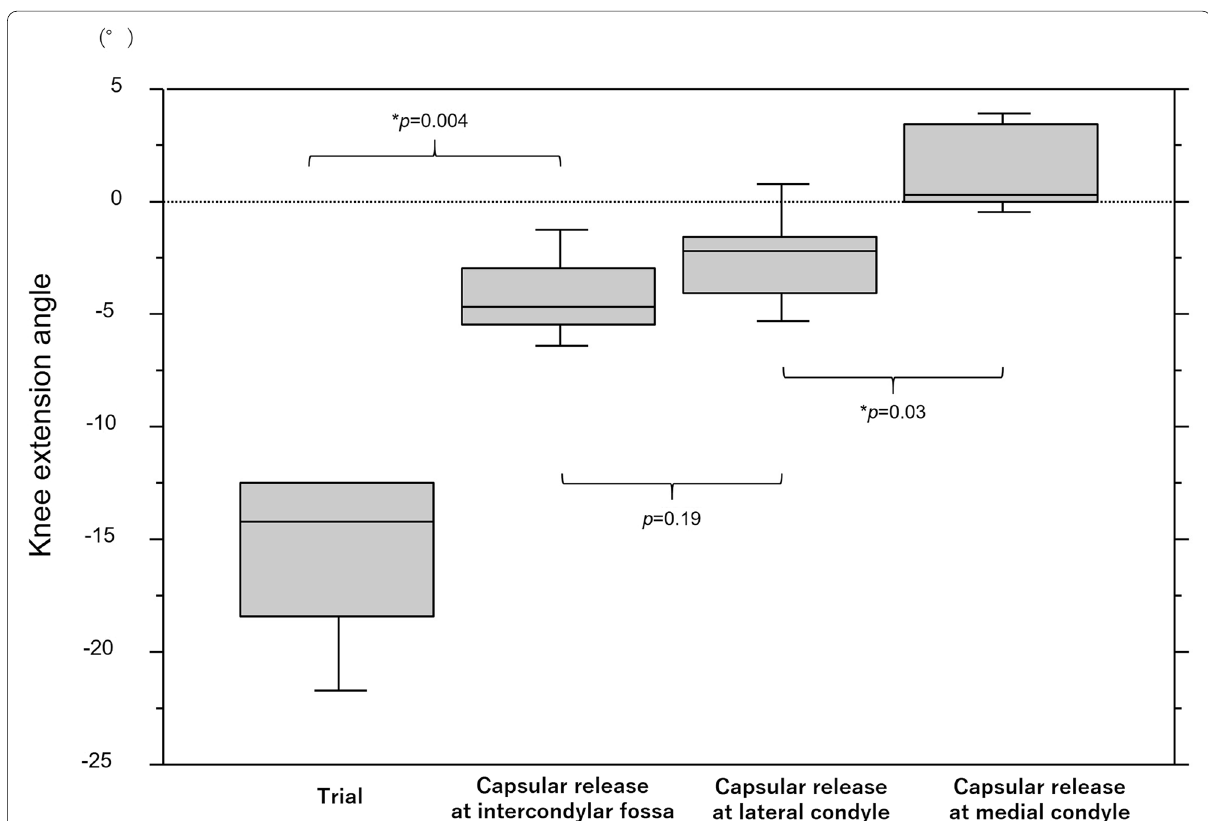
and after capsular release at each step ( p <